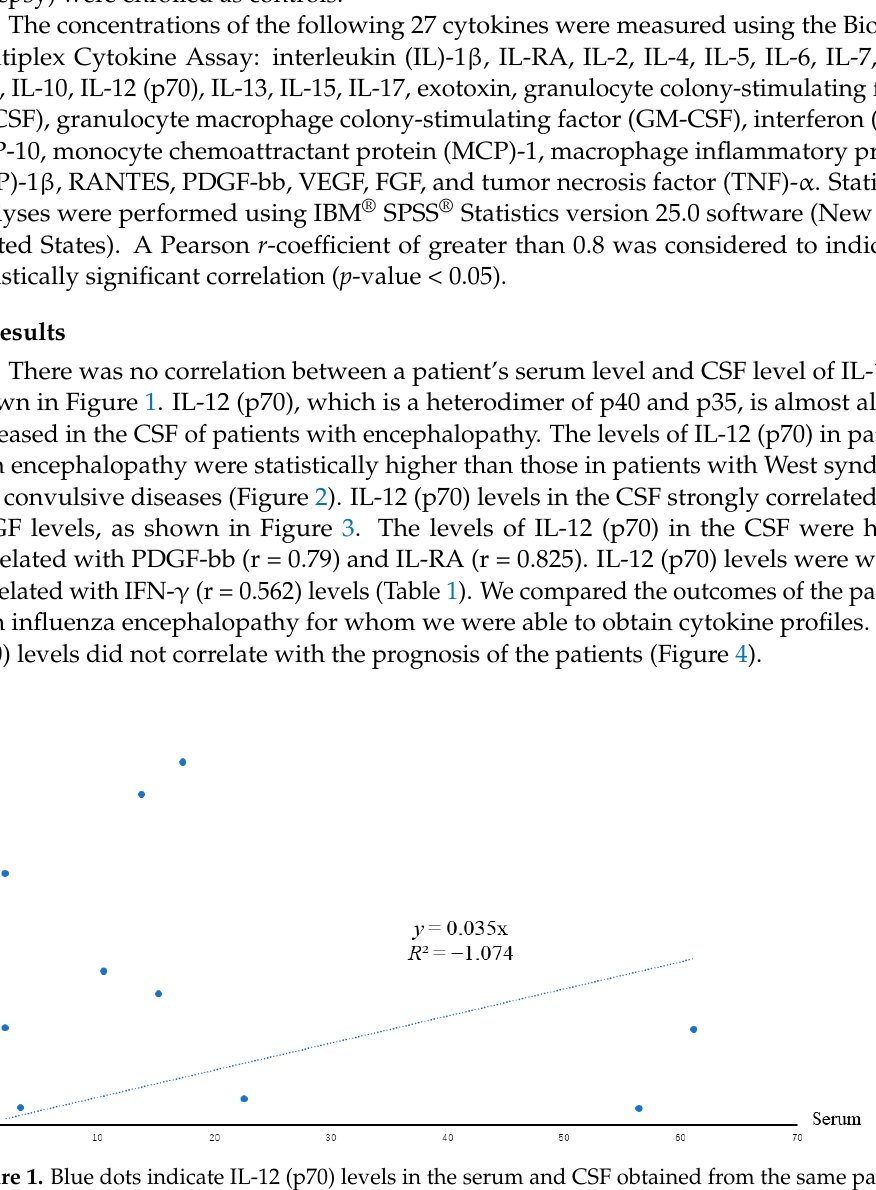
Figure 1. Blue dots indicate IL-12 (p70) levels in the serum and CSF obtained from the same patients. The line represents approximate straight line (R is coefficient of determination).